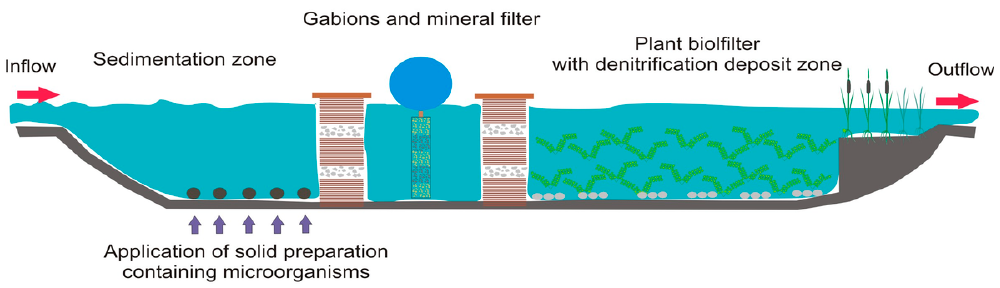
Figure 2. Overview of section A located on the pond and its segments: 1—sedimentation and biological activity segment—the place of application of the Micro-Dictum preparation; 2—filtration segment with wicker gabions and mineral filter; 3—plant biofilter segment with the applied denitrification deposit (the segments were described in detail in the beginning of Section 2.2).